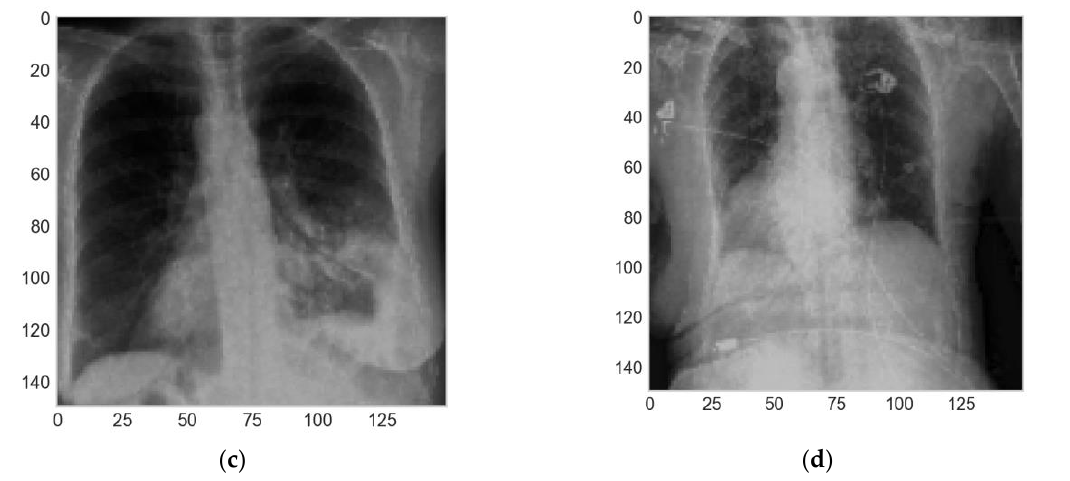
Figure 3. Comparison of the original and augmented images: ( a ) original image from CheXpert dataset; ( b ) original image from ChestX-ray14 dataset; ( c , d ) augmented images after preprocessing.